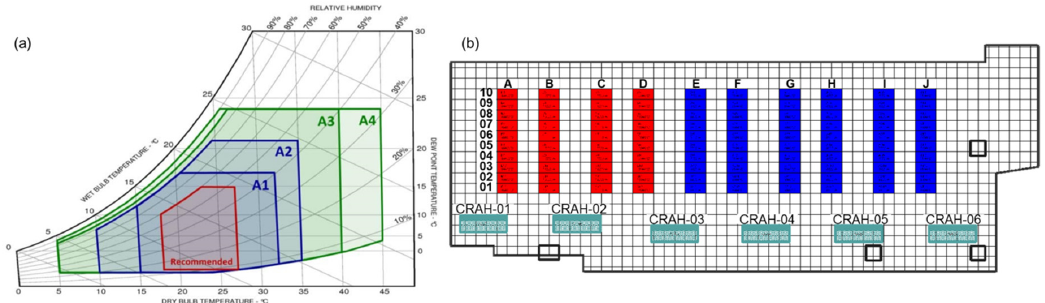
Figure 8. ( a ) Identification number of server racks and CRAH units and ( b ) American Society of Heating, Refrigerating, and Air-Conditioning Engineers (ASHRAE) environmental classes for data centers (2015).